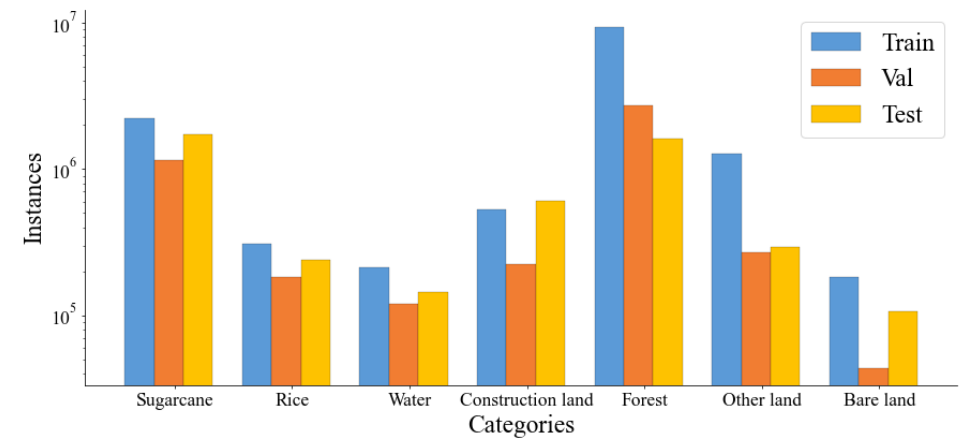
Figure 3. Class-label instances for study area dataset I. Note: The y -axis is logarithmic to account for the disparity in the number of